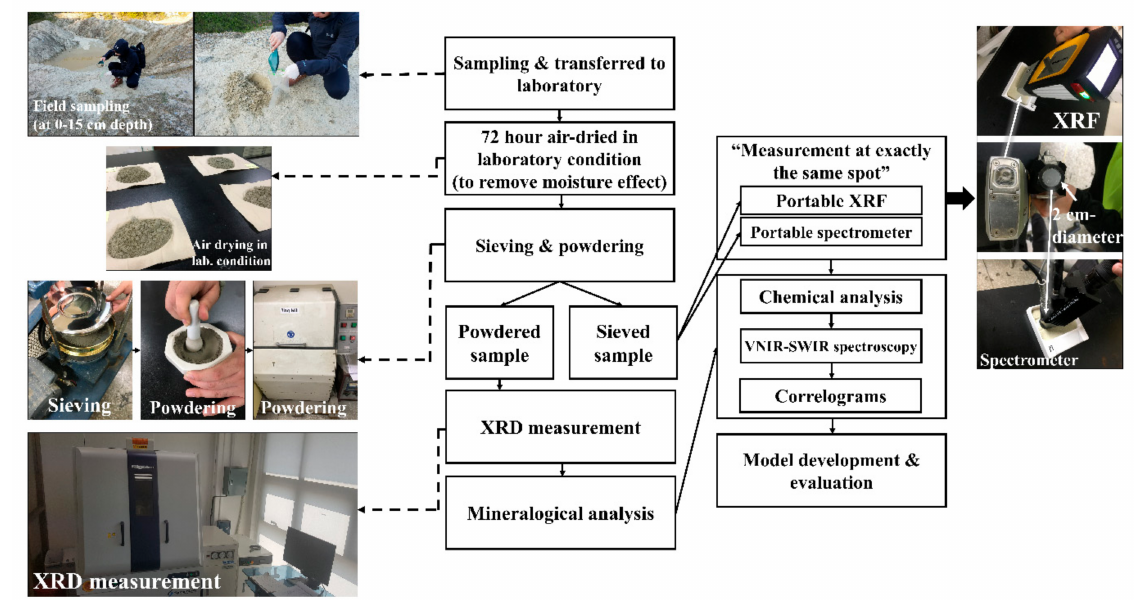
Figure 2. Overall flow chart of pre-processing and method development used in this study and photographic